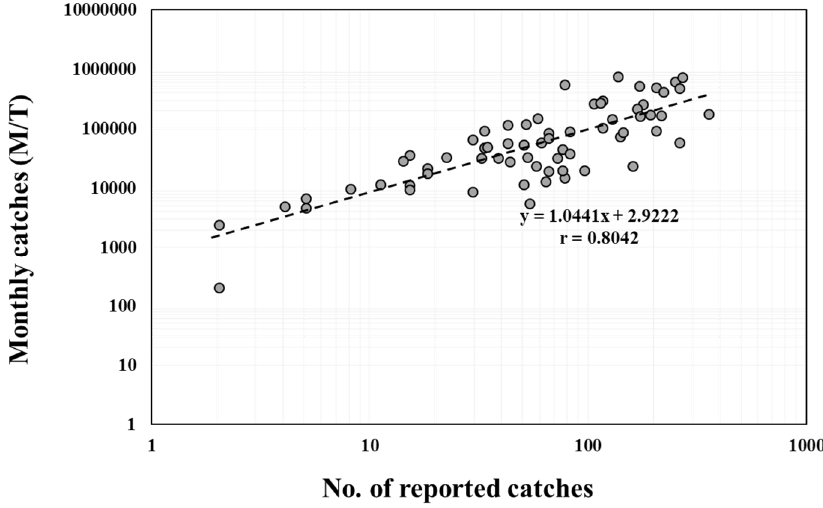
Figure 2. Correlation between logarithmic monthly catches and amount of reported catches ( n = 67).